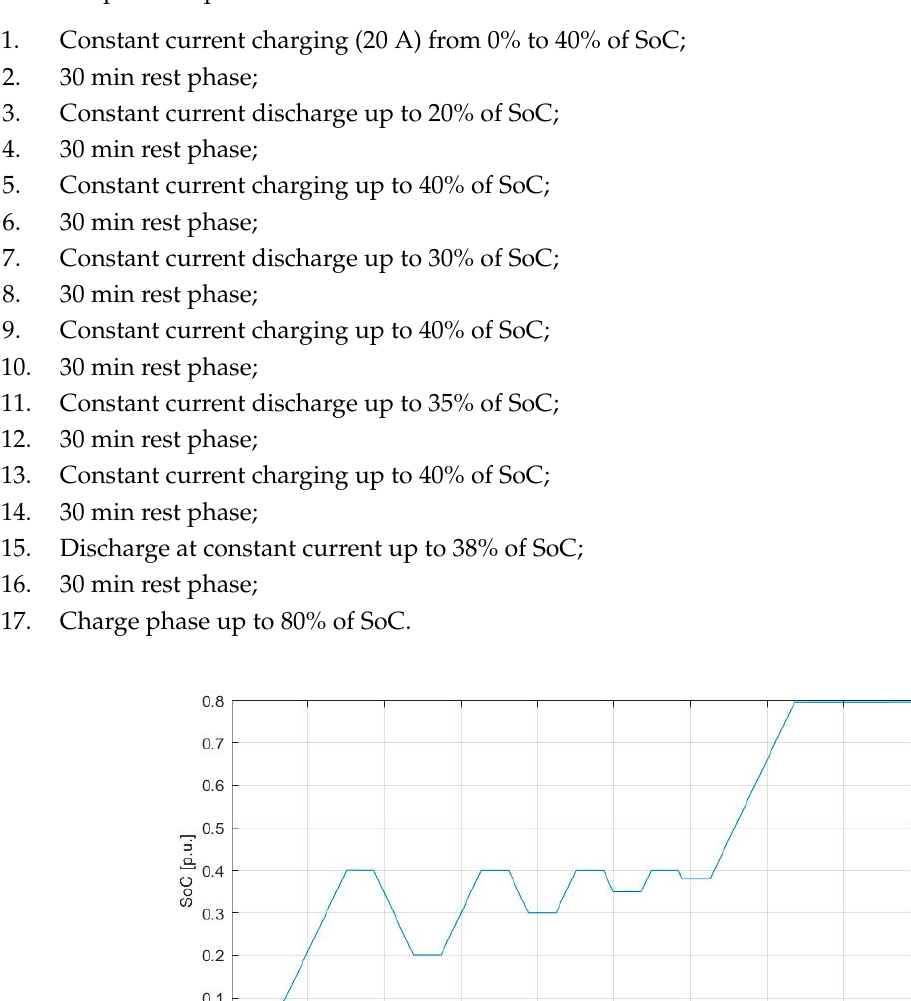
Figure 16. Results without hysteresis modeling. On the other hand, considering the enhanced model, where the lambda parameter and its variations are taken into account, the results shown in Figure 17 were obtained. In this case, a significantly smaller difference can be observed between the modeled and measured voltage.